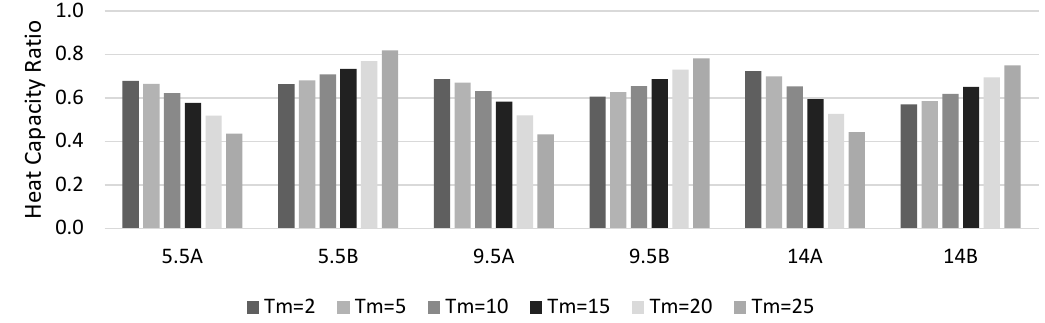
Figure 7. Heat capacity ratios for all simulated cases for heat exchanger 1.